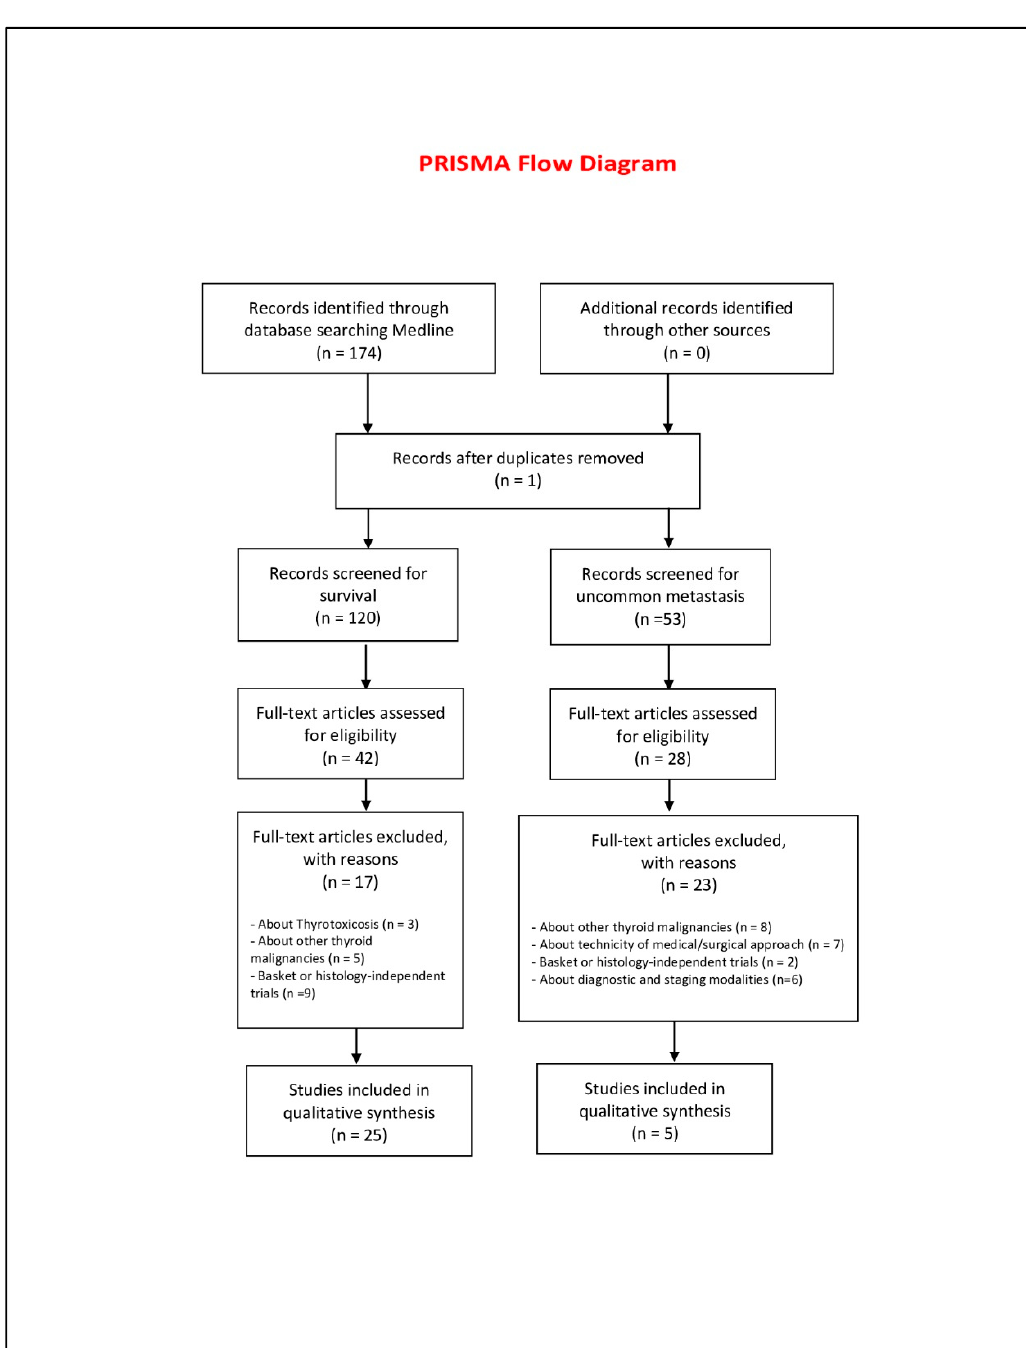
Figure 1. Prisma 2009 flow diagram. [9].